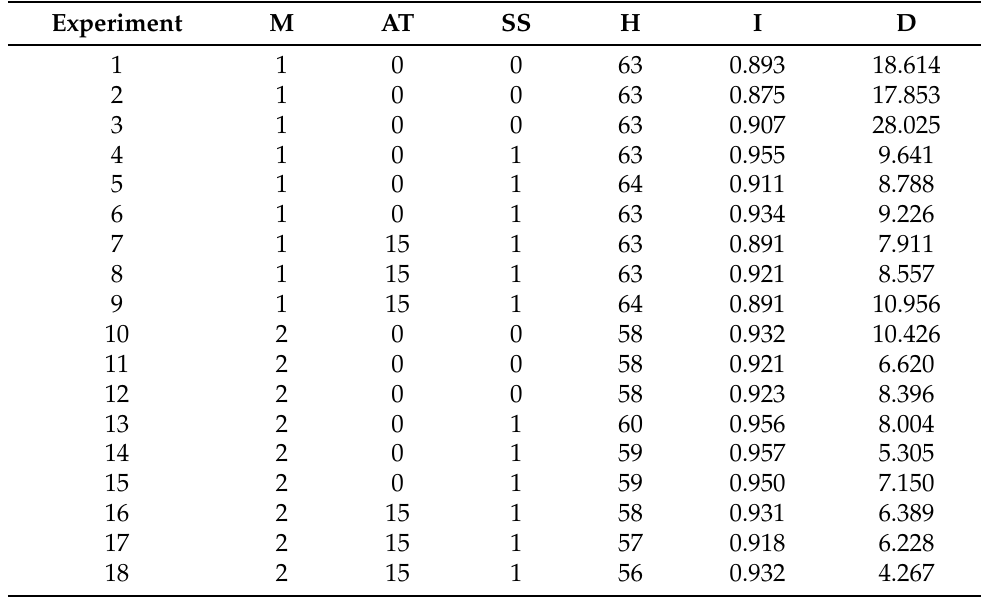
Table 4. Experimental design matrix and the corresponding values of response